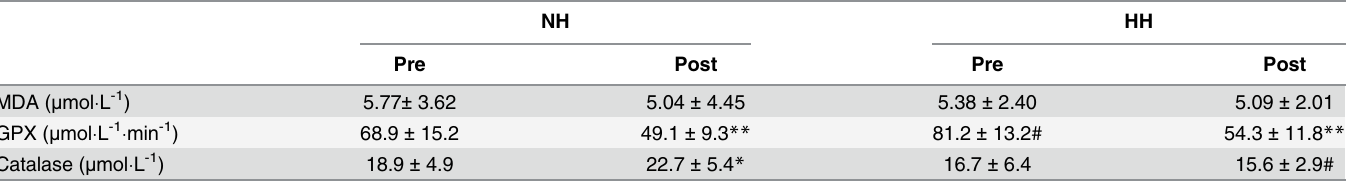
Table 2. Plasma values of select oxidative stress and antioxidant markers obtained before (Pre) and immediately following (Post) the live-high train-low (LHTL) protocol in NH and